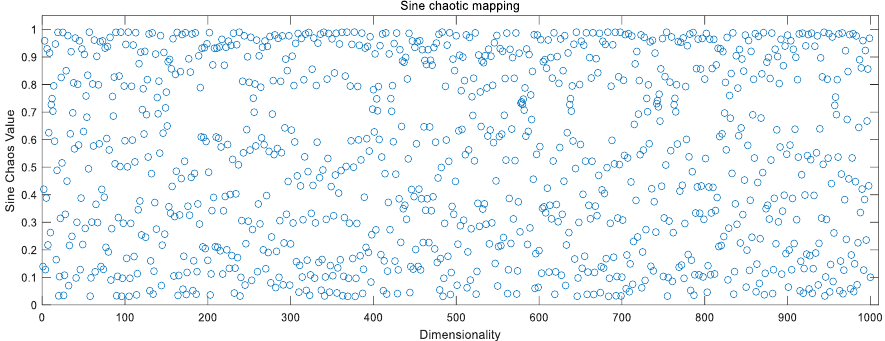
Figure 2. Sine chaotic mapping values.